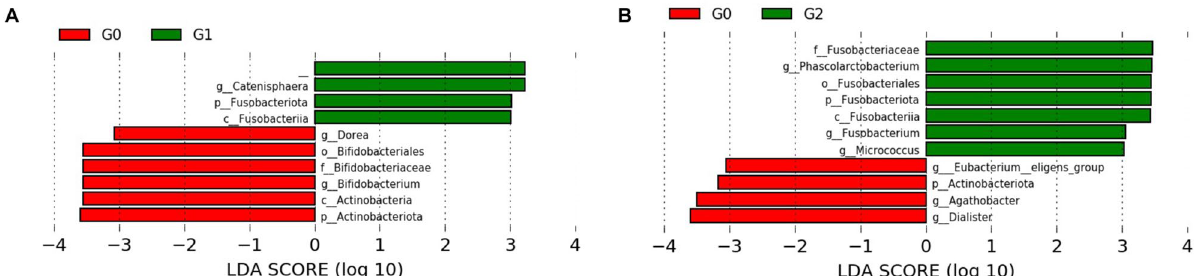
Figure 4. Linear discriminant analysis effect size (LEfSe) analysis identified the most differential microbiota between G0 and G1 ( A ), and G0 and G2 ( B ). The LDA score also indicates the effective size and ranking of each differentially abundant taxon (LDA score > 3.0; alpha value p < 0.05). Plots were depicted using LEfSe from the Galaxy platform of the Huttenhower lab. G0: no renal stones (control); G1: incidental renal stones; and G2: prevalent renal stones.